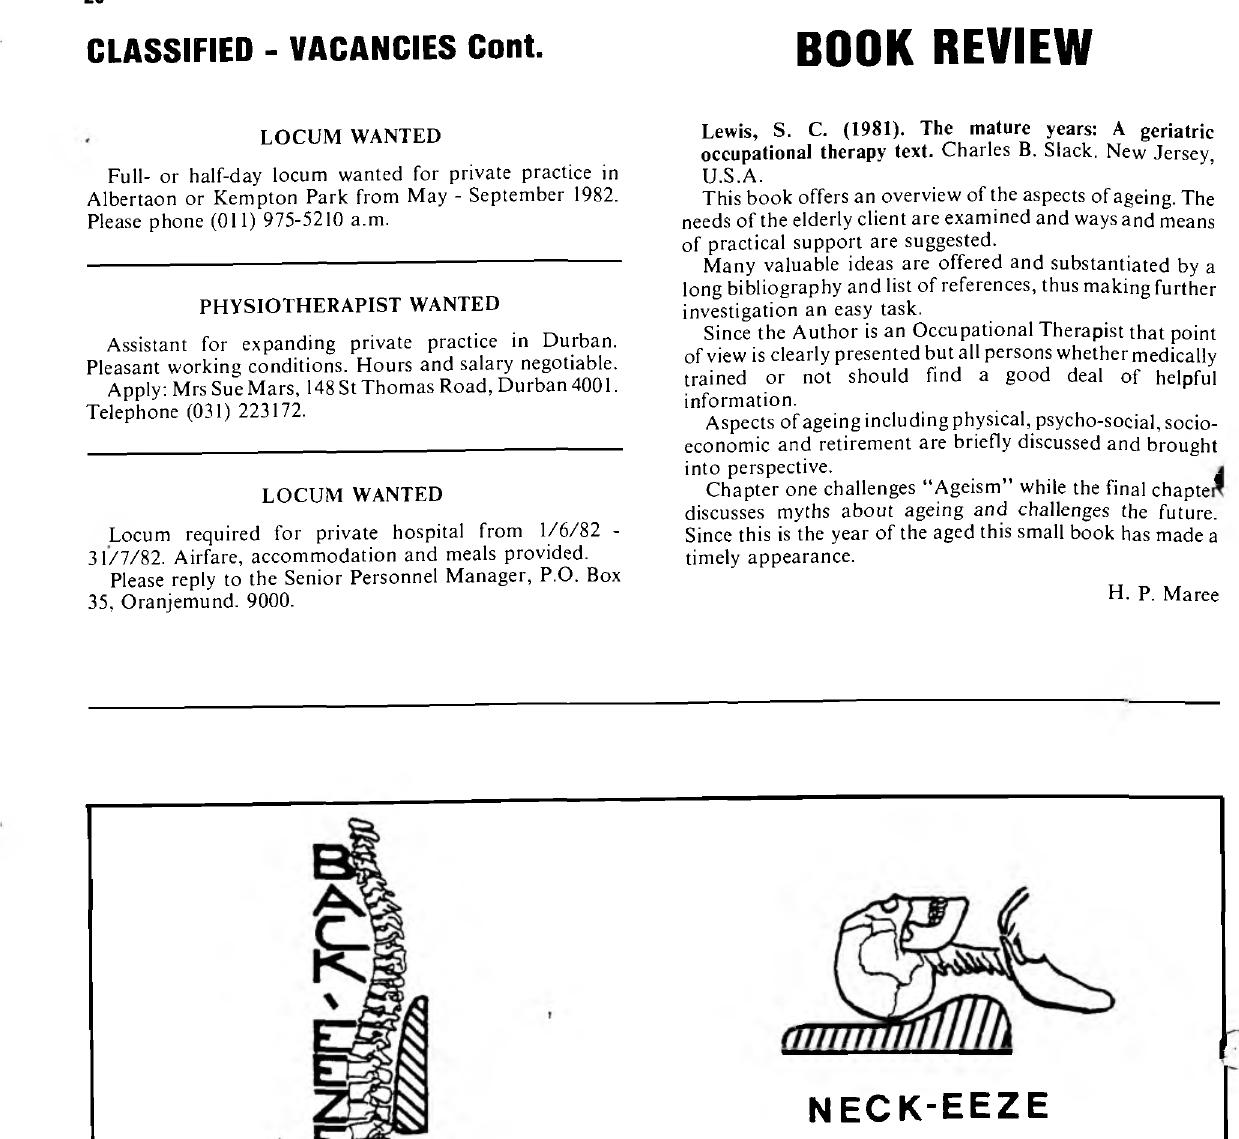
— fits into standard pillow case — high quality foam Retail price: R12.00